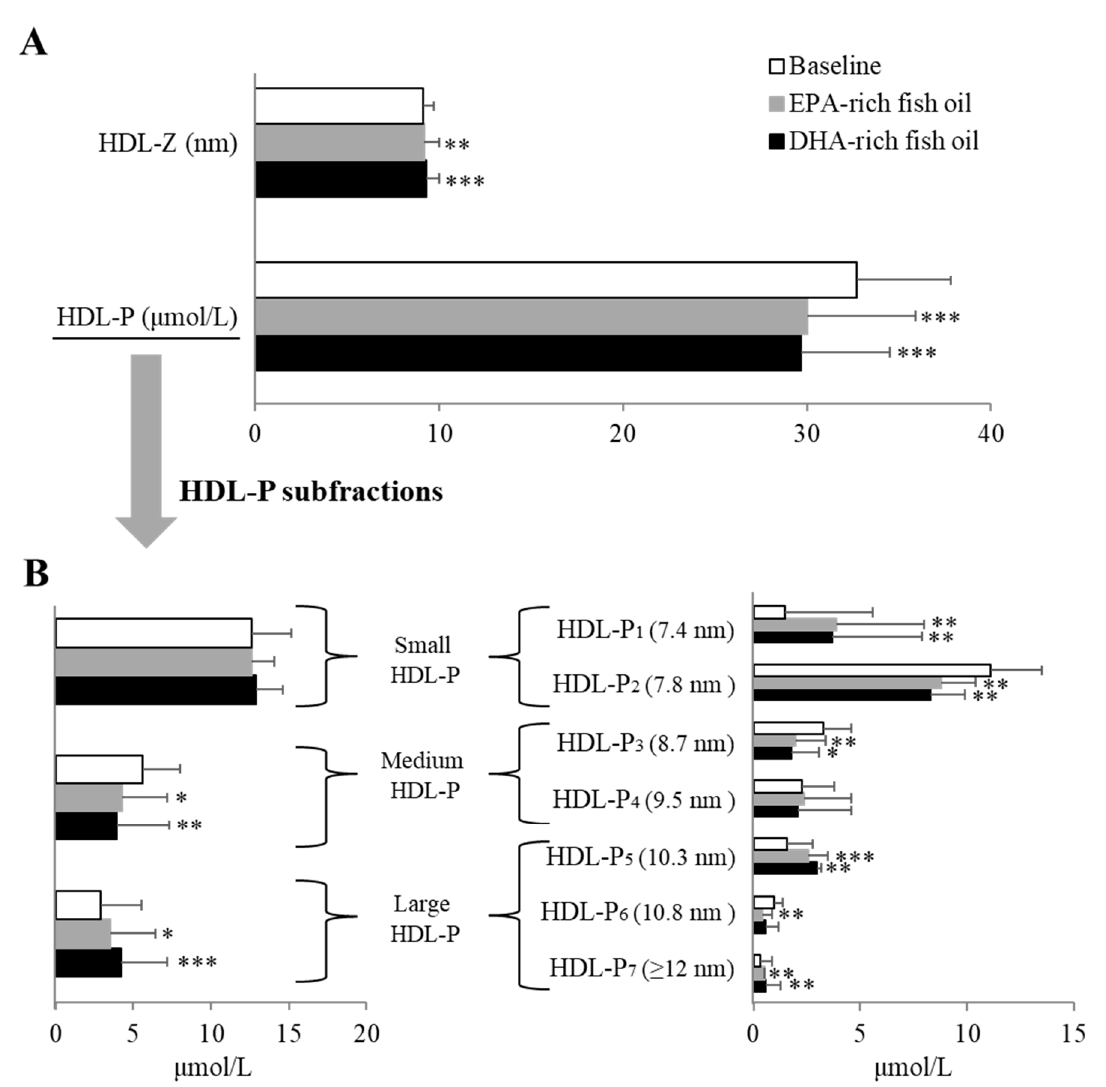
Figure 4. Changes in overall HDL particle size / number ( A ) and HDL particle subfraction number ( B ) after an 8-week dietary supplementation with EPA-rich or DHA-rich fish oils. HDL-Z: HDL particle size; HDL-P: HDL particle number. HDL-P1~7: HDL subspecies fraction 1~7. Data represented as mean ± SD (n = 30). * p < 0.05, ** p < 0.01, and *** p < 0.001 compared with baseline.